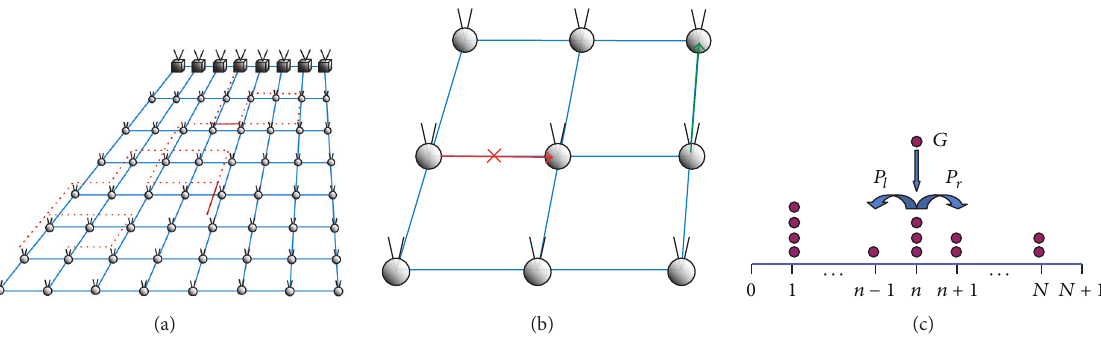
Figure 1: (a) An illustration of a uniform wireless sensor network over a 2D domain. Destination nodes are located at the far edge. We show the possible path of a message originating from a node located in the left-front region. (b) An illustration of the collision protocol: reception at a node fails when one of its other neighbors transmits (regardless of the intended receiver). (c) An illustration of the time evolution of the queues in the 1D network